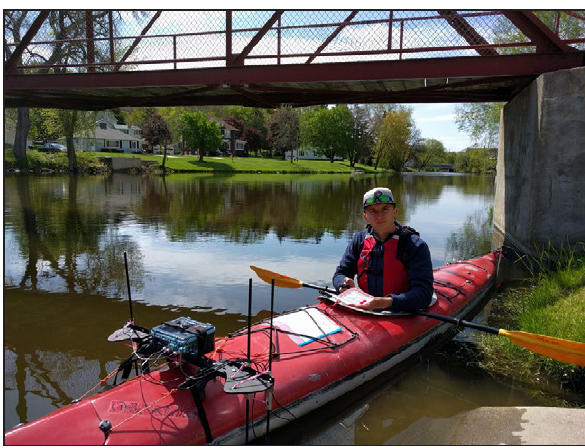
Figure 3: Prototype installed on the front of a kayak with flexible probe mounts. Photo by Eric Compas.